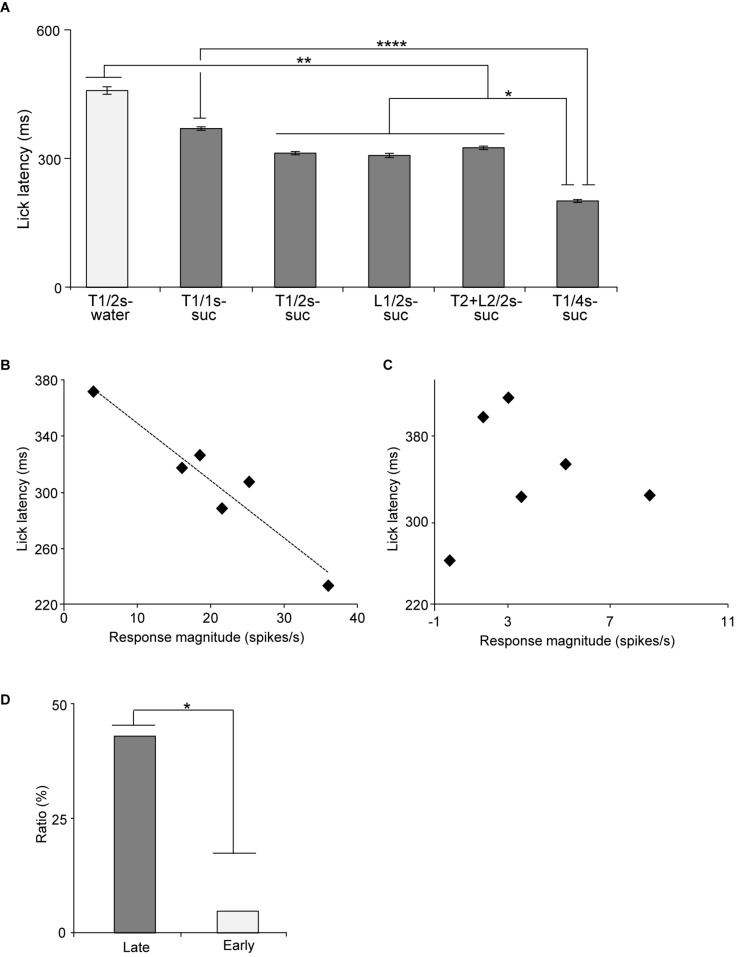
Relationships between mean lick latencies and mean response magnitudes to the CSs associated with reward in the early and late CS+-selective neurons. (A) Mean lick latencies after offset of the CSs associated with reward during recording of the late CS+-selective neurons (n = 20). (B) An example of a late CS+-selective neuron showing a significant negative correlation between mean lick latencies and mean response magnitudes to the rewarding CSs (p = 0.003, simple linear regression). (C) An example of an early CS+-selective neuron showing no significant correlation between mean lick latencies and mean response magnitudes to the rewarding CSs (p = 0.926, simple linear regression). (D) Comparison of the ratio of neurons with significant negative correlation between late and early CS+-selective neurons. T1/2s-water, 2-s Tone1 associated with water; T1/1s-suc, 1-s Tone1 associated with sucrose; T1/2s-suc, 2-s Tone1 associated with sucrose; L1/2s-suc, 2-s Light1 associated with sucrose; T2 + L2/2s-suc, 2-s Tone2 + Light2 associated with sucrose; T1/4s-suc, 4-s Tone1 associated with sucrose. *, **, ****p < 0.05, 0.01, and 0.0001, respectively.